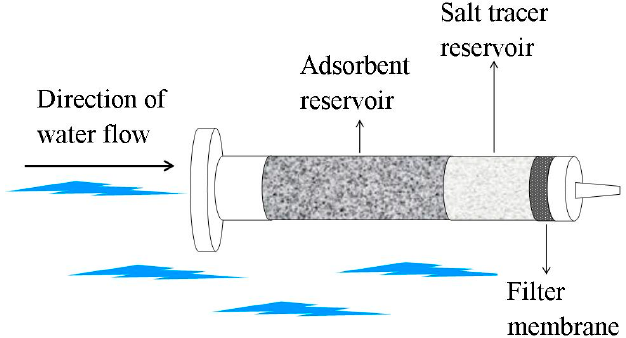
Figure 4. Components of a SorbiCell passive sampler.